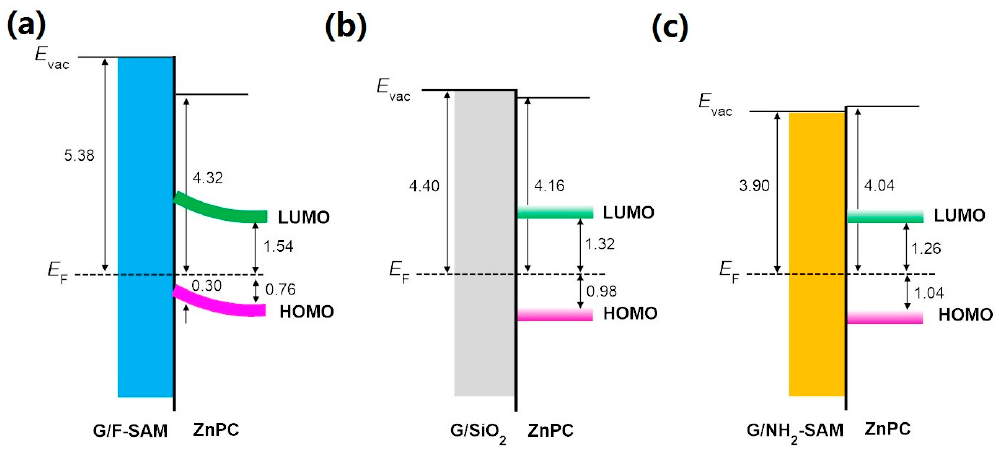
Energy level diagrams of ( a ) ZnPc / graphene on F-SAM, ( b ) ZnPc / graphene, and ( c ) ZnPc / graphene on NH 2 -SAM.